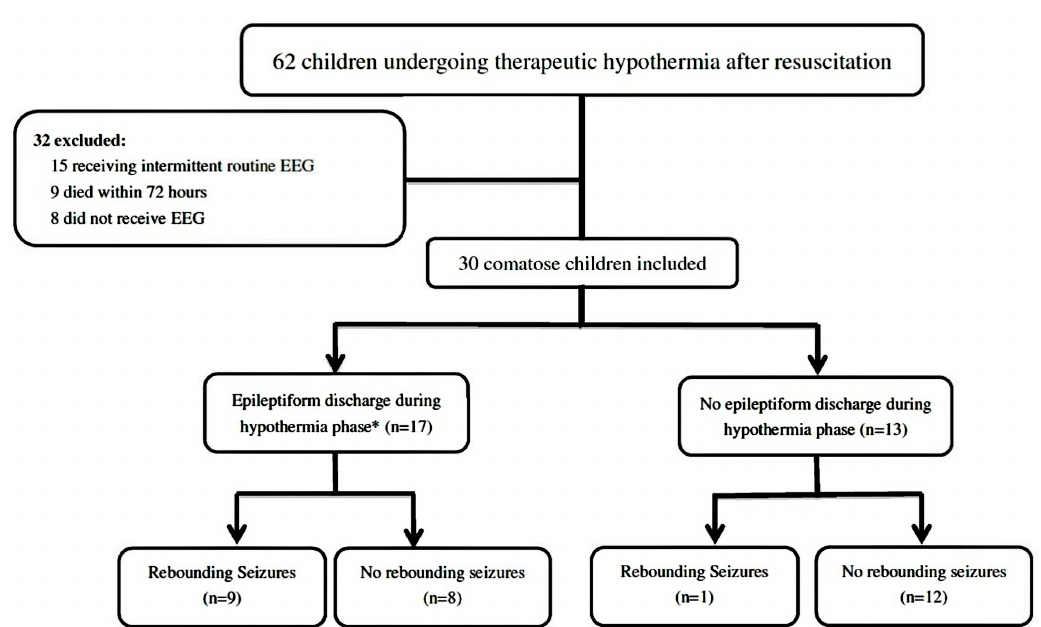
Figure 1. During the 10-year study period, 62 children undergoing therapeutic hypothermia after resuscitation were identified, of whom 30 (48.4%) patients met the study entry criteria. We excluded refractory cardiogenic shock despite the use of vasopressor and/or inotropic agents, and eight who did not receive EEG monitoring. Epileptiform discharges (interictal, ictal, or both) during